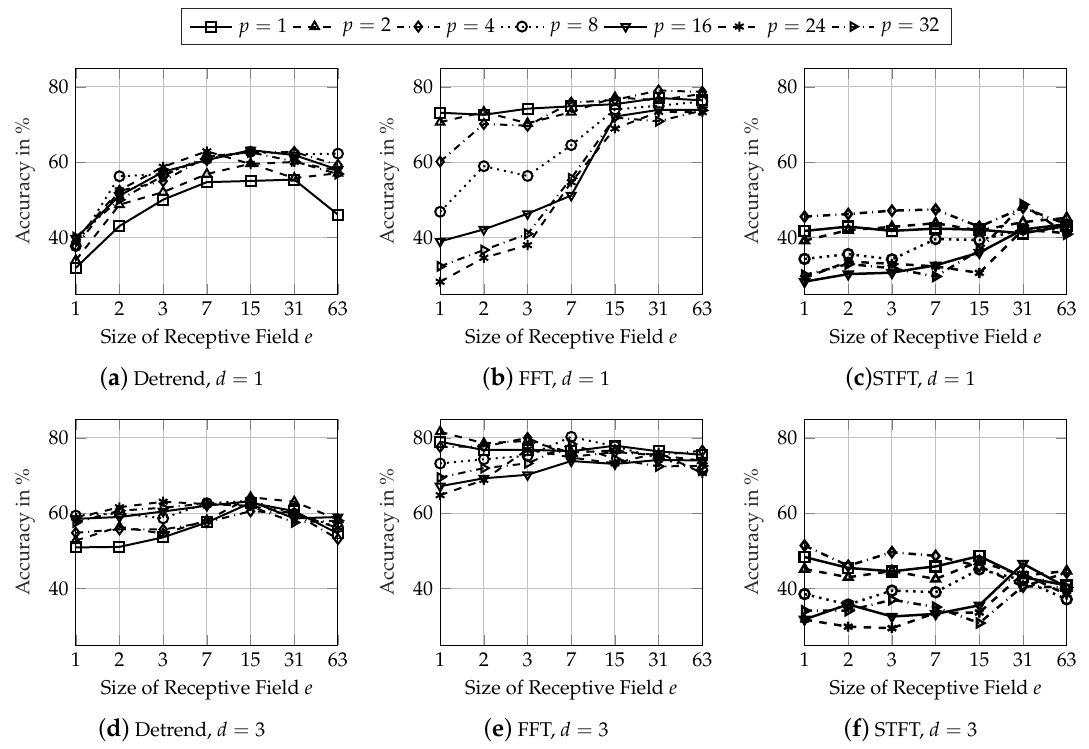
Figure 8. Mean accuracy of the 5-fold cross validation network architectures from Figure 5 applied to the tire variation